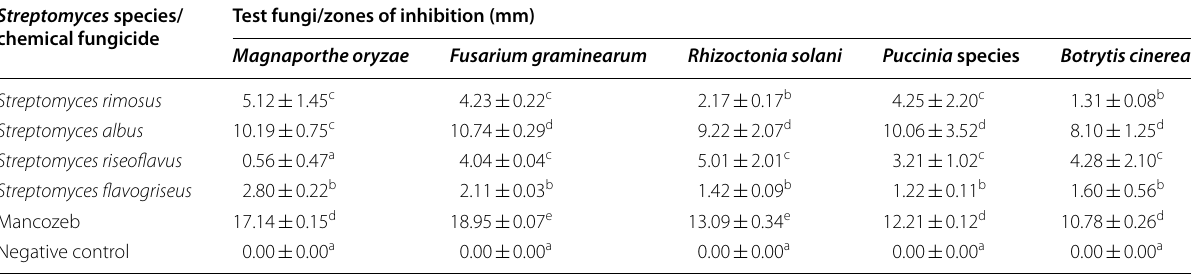
Values are expressed in mean